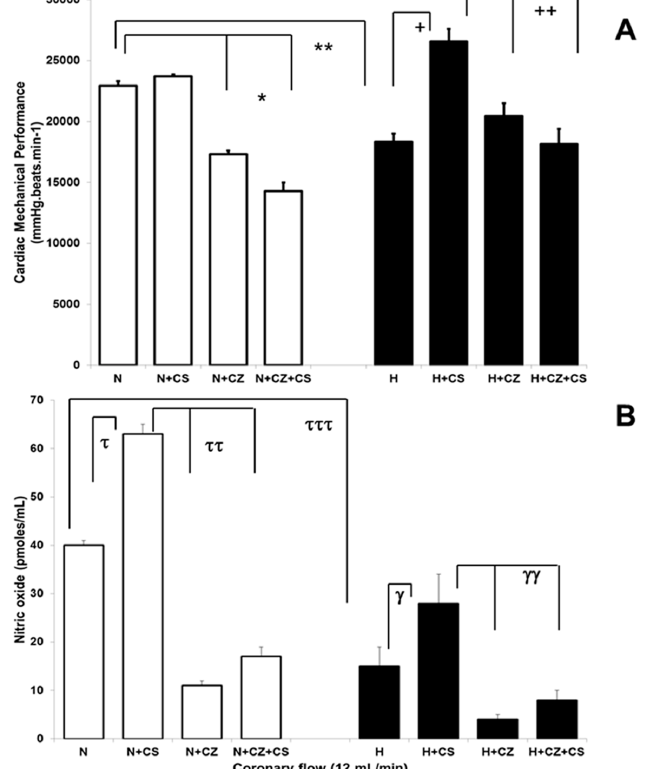
Figure 3. Cardiac mechanical performance ( A ) and nitric oxide levels in liquid effluent ( B ) in isolated heart of normotensive and hypertensive rats (withe and black bars respectively) in presence or absence of capsaicin (CS) and capsazepine (CZ) treatments. Values represent the mean ± standard deviation of n = 6, (*, **, + , ++ , τ , ττ , τττ , γ , γγ ) p ≤ 0.05, by Newman’s post hoc test.